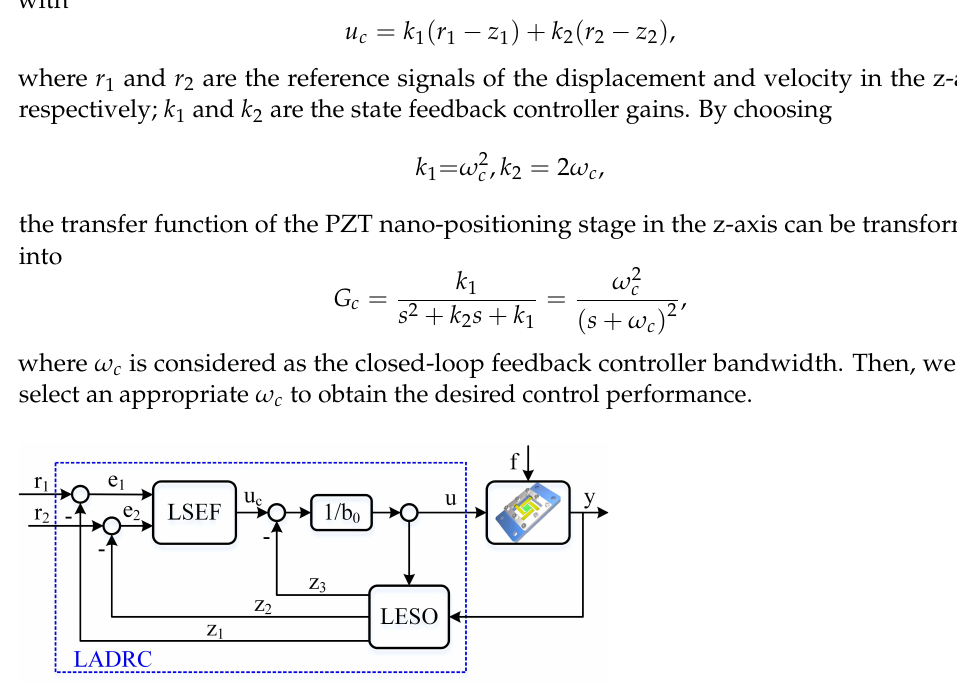
Figure 6. Block diagram of the linear